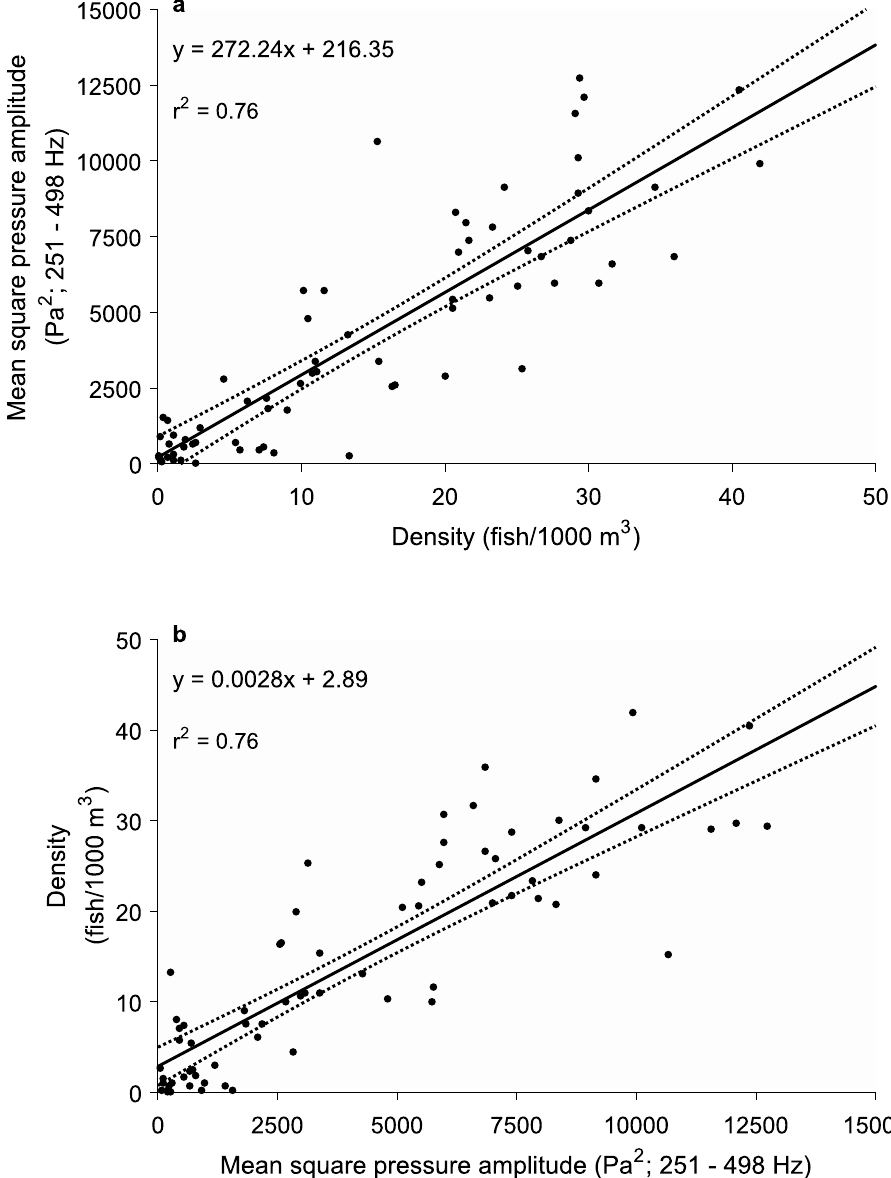
Figure 6. Relationship between sound levels and fish density during the peak spawning period. ( a ) Mean square pressure amplitude ( p 2 ; Pa 2 ; 251–498 Hz) as a function of density ( ρ ; fish/1000 m 3 ) for measurements during the first two hours after high tide and ( b ) the modeled relationship generated for estimating ρ from future measurements of p 2 , (F 1,68 = 216, p < 0.001). Dotted lines indicate 95% confidence intervals. Densities are mean densities per 150-m survey length that were nearest in space and time to sound measurements. See Supplementary Fig. S4 for the modeled relationships using mean density per 300-m survey